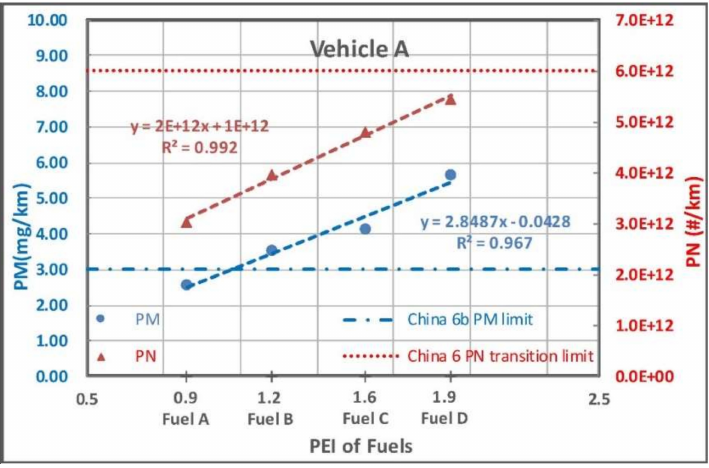
Figure 9. PEI vs. PM and PN emissions from Vehicle